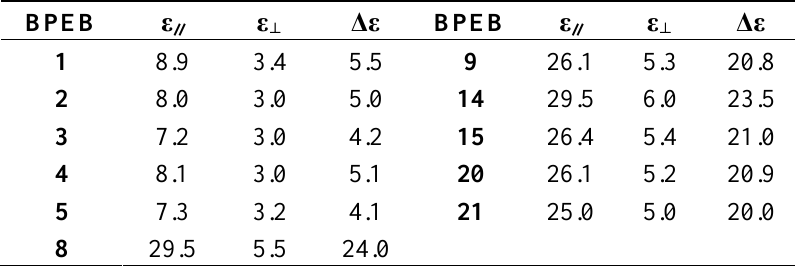
Table 3. Δε values of